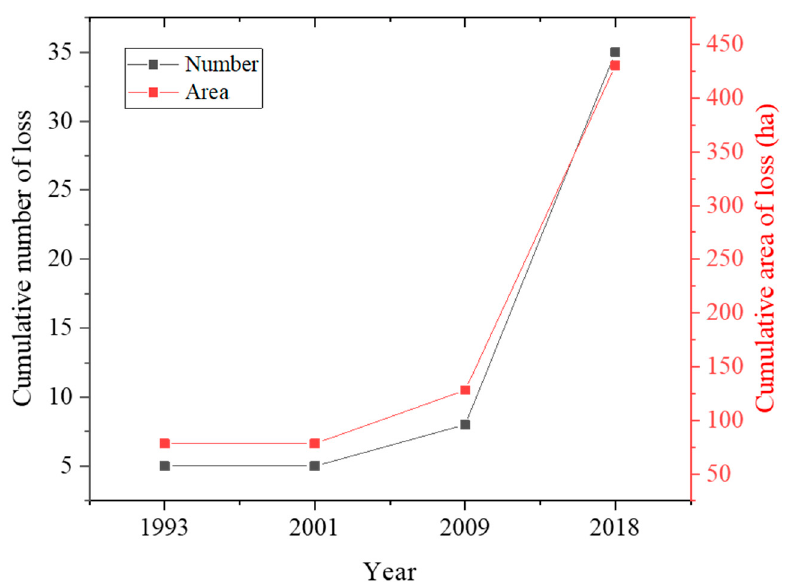
Figure 7. The cumulative numbers and areas of loss for forest patches that were fully transformed into other land-use/cover